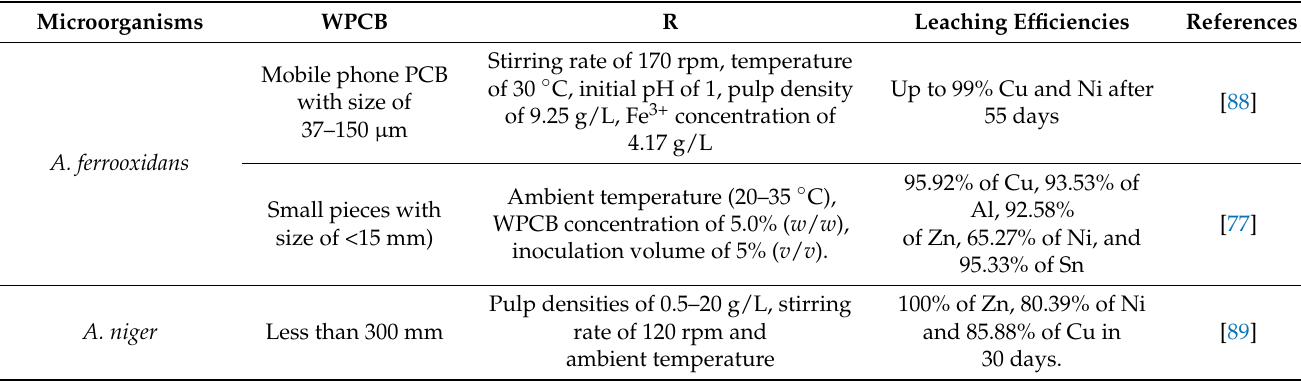
Table 2. Recent research on the bioleaching of